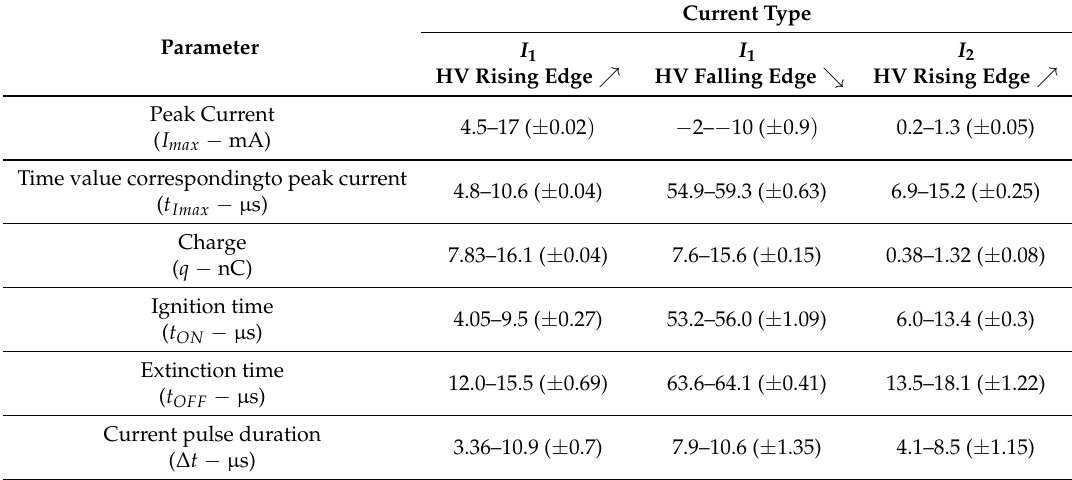
Table 2. The influence of operational parameters on discharge current characteristics and maximum standard